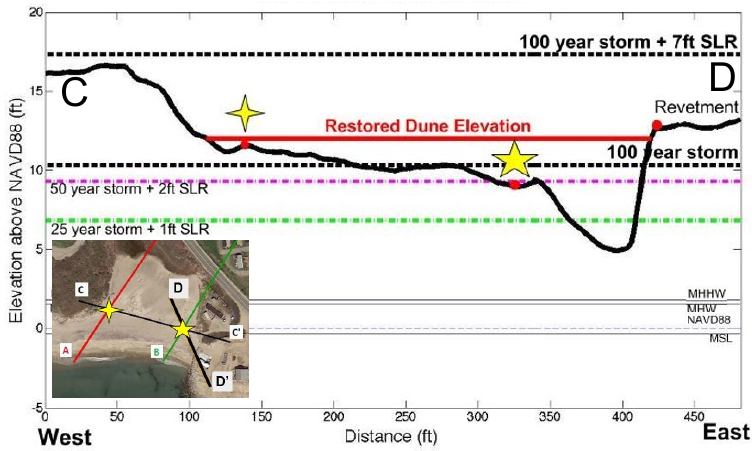
Figure 18. Cross section of southwest corner of the study area where a reinforced dune is proposed to mitigate damage from a 100 year storm event.